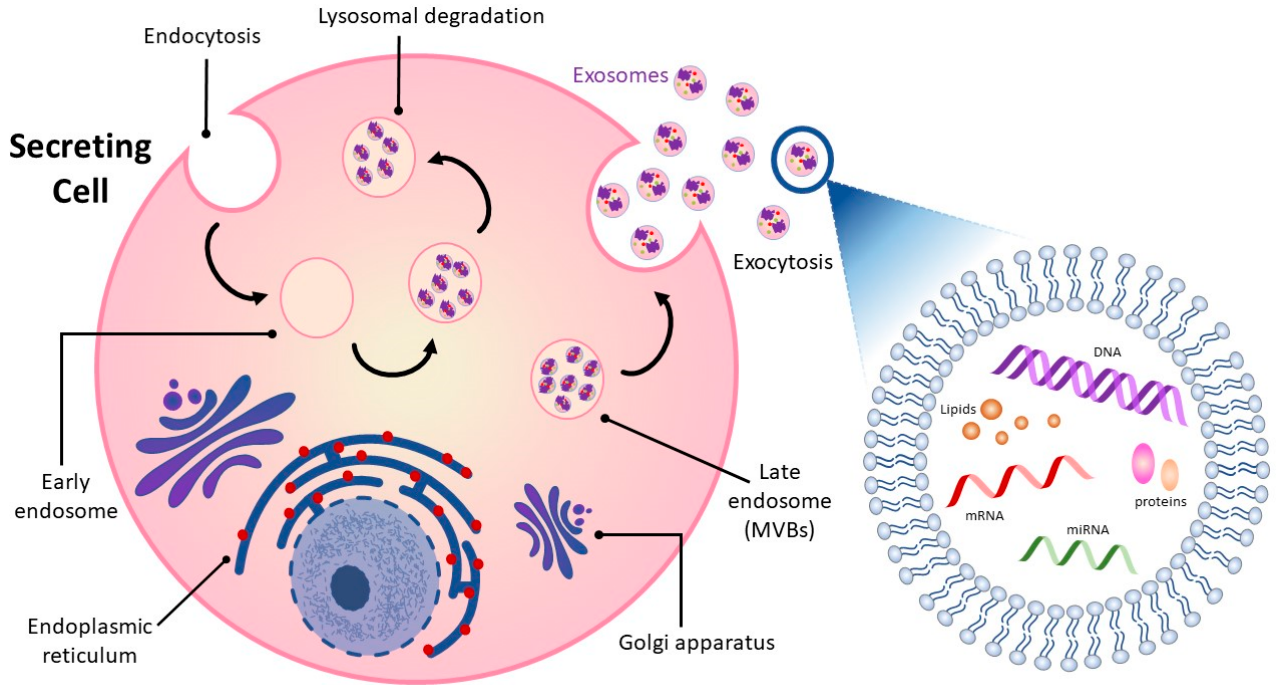
Figure 1. Exosome biogenesis and exosome cargo. Exosomes originate as intraluminal vesicles contained within multi-vesicular bodies (MVBs) and are formed via outward budding of the plasma membrane. Exosome content is cell-specific and contains noncoding RNA, such as miRNA and mRNA, lipids, and proteins. These contents play a vital role in intercellular communication as they reflect the pathophysiological state of the secreting cell.